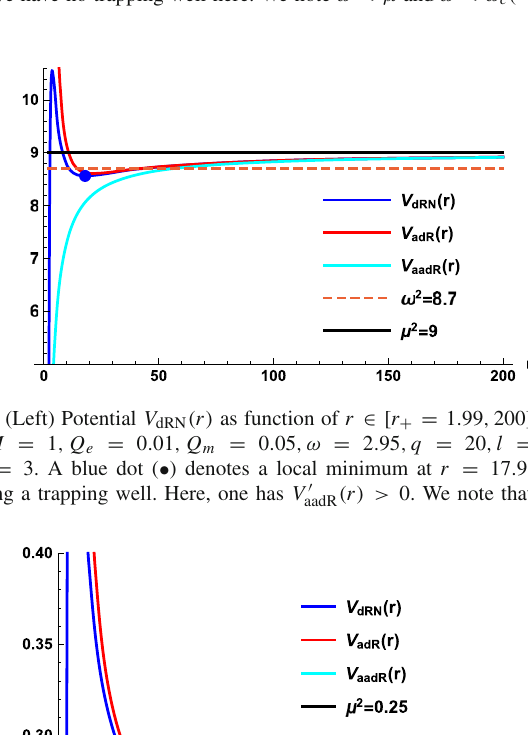
Fig. 1 (Left) Potential V dRN ( r ) as function of r ∈ [ r + = 1 . 77 , 100 ] with M = 1 , Q e = 0 . 4 , Q m = 0 . 5 ,ω = 0 . 02 , q = 2 , l = 2 ,μ = 0 . 05. We have no trapping well here. We note ω < μ and ω < ω c ( =